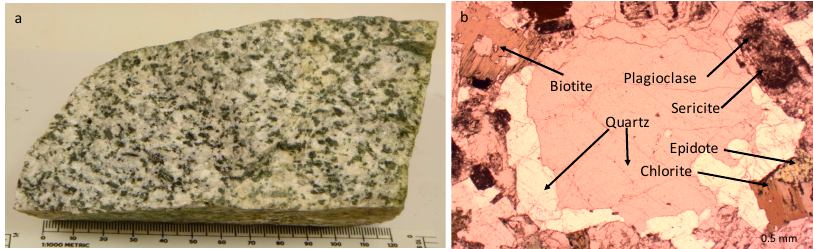
Figure 3. Host rock mineralogy and alteration. ( A ) Granodiorite with phaneritic texture; ( B ) Transmitted light microscopy image from granodiorite, biotite present chlorite-epidote alteration, and plagioclase present weak sericitic alteration.